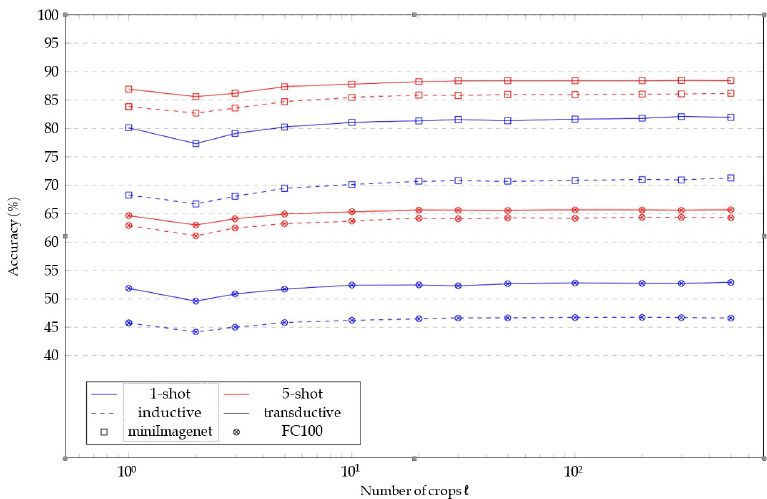
Figure A2. Ablation study of augmented samples; we performed 10 5 runs for each value of (cid:96) .